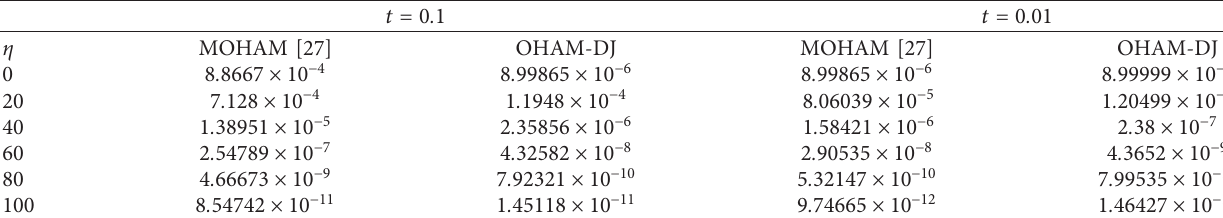
Table 1: Absolute errors obtained by first-order OHAM-DJ and comparison is made with MOHAM of ζ ( η , t ) at t � 1 , ω � 1 . 5 ,l � 0 . 1 ,C � 1 . 5 , and C � 0 . 1. 0 2